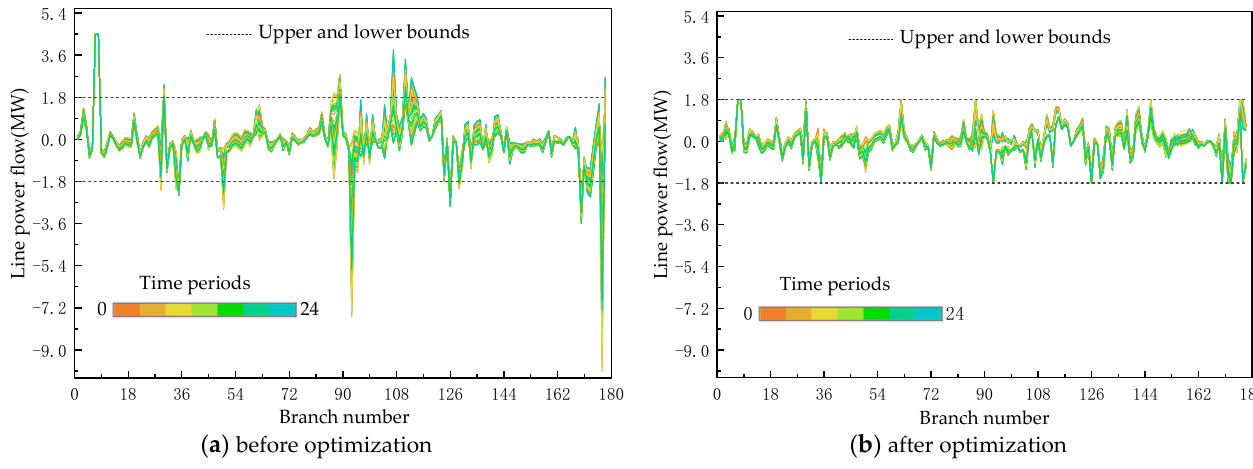
Figure 5. Power flow of 178 branches at 24 periods before and optimization.